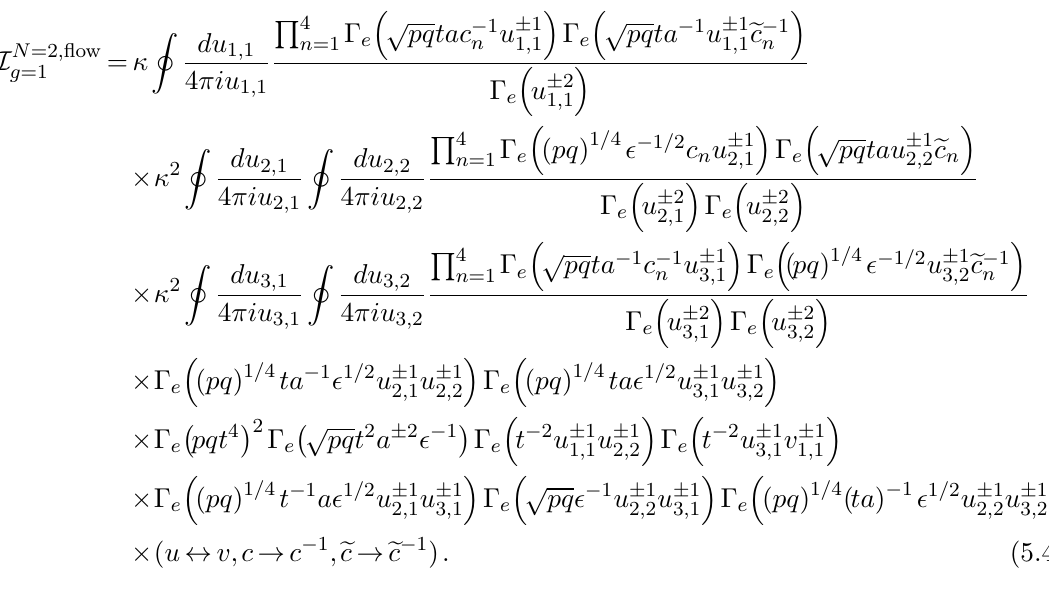
Figure 18 . Quiver diagrams of the theory resulting from the RG-(cid:13)ow starting at the class S D torus. The dashed lines indicate that one needs to add the same (cid:12)gure again with u ! v and replacing all the fundamental and anti-fundamental representations of both SU(4)